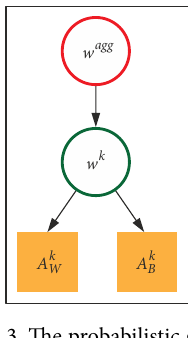
Figure 3. The probabilistic graphi- cal model of the Bayesian BWM (Mohammadi & Rezaei,